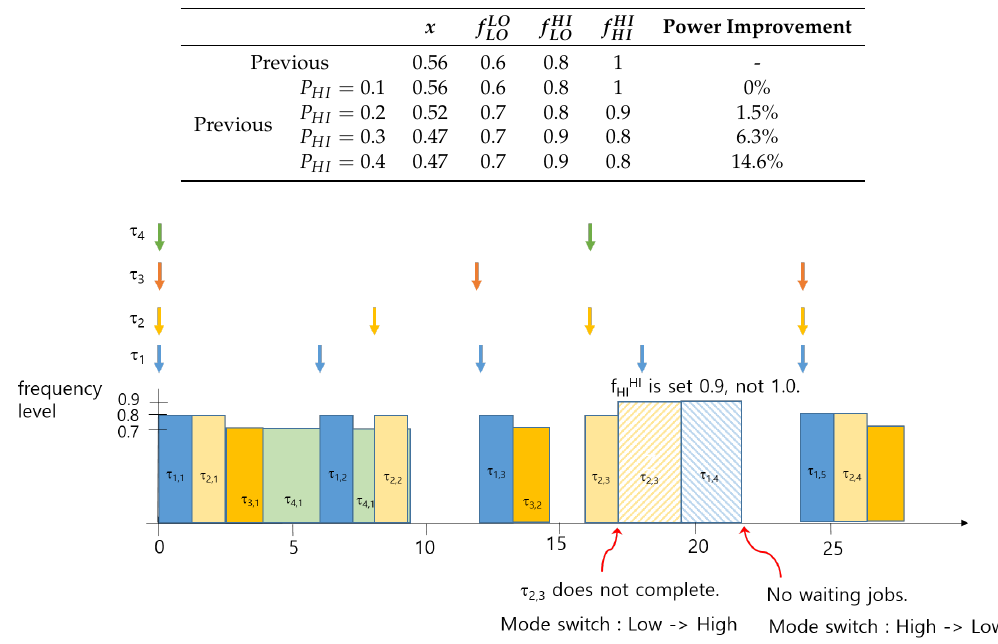
Table 3. Optimal frequency levels and x of the example of Table 1.